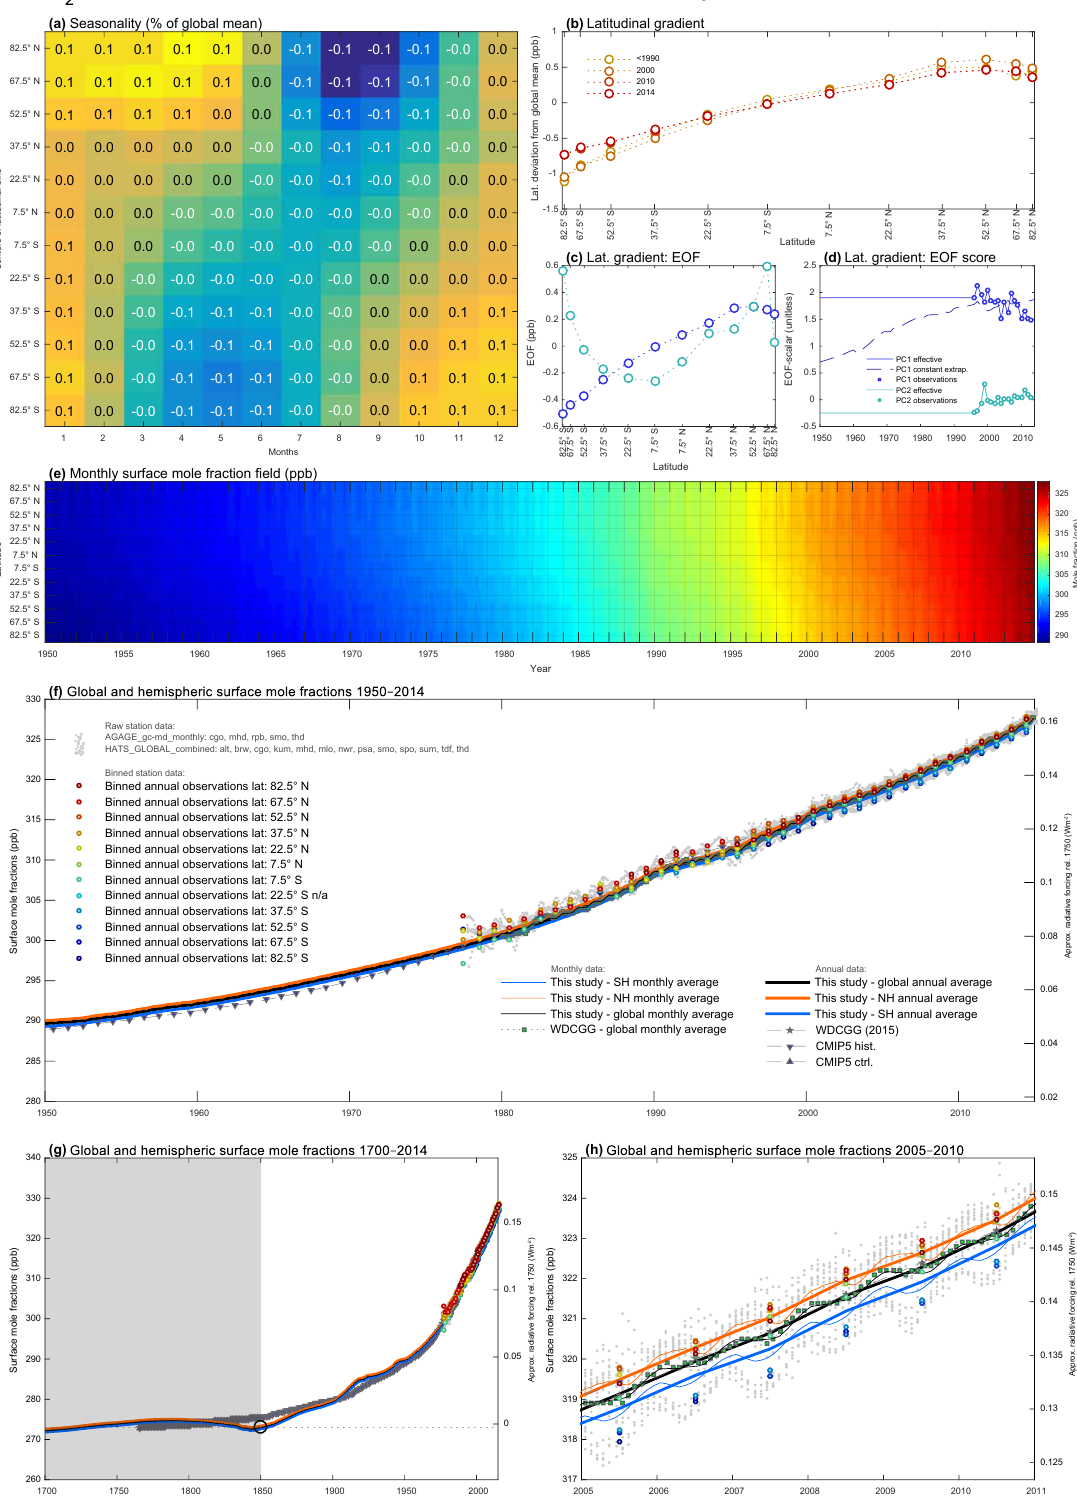
PC2 observations